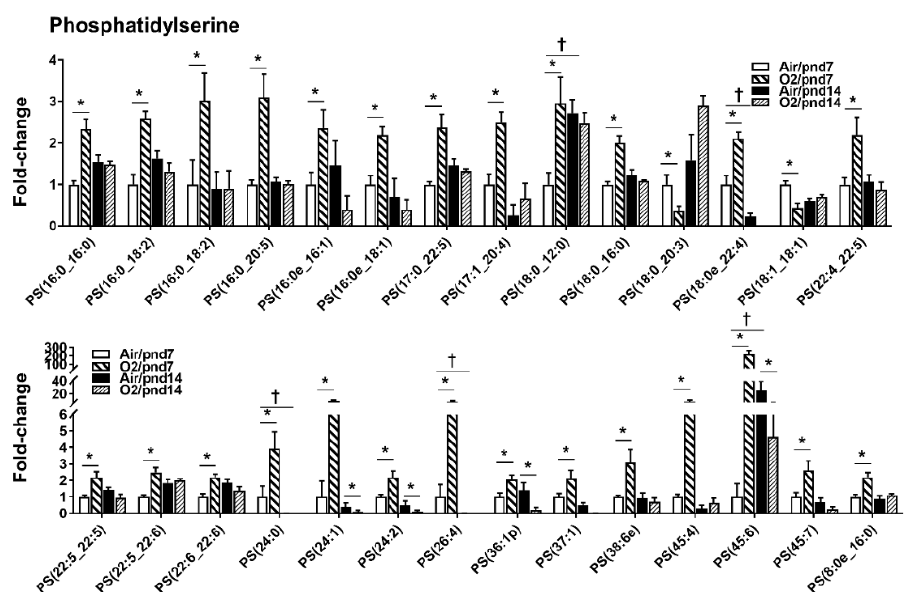
Figure 6. Compositional changes of lung PS species in mice exposed to hyperoxia as neonates. PS species in mouse lungs with 2-fold change and p < 0.05 between air and hyperoxia groups at pnd7 and pnd14 were listed. n = 6. * p < 0.05 vs. corresponding air; † p < 0.05 vs. air / pnd7.